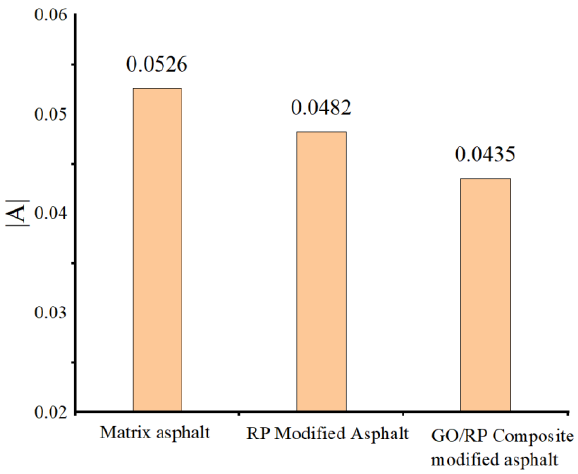
Figure 2. Three original asphalt |A| values.